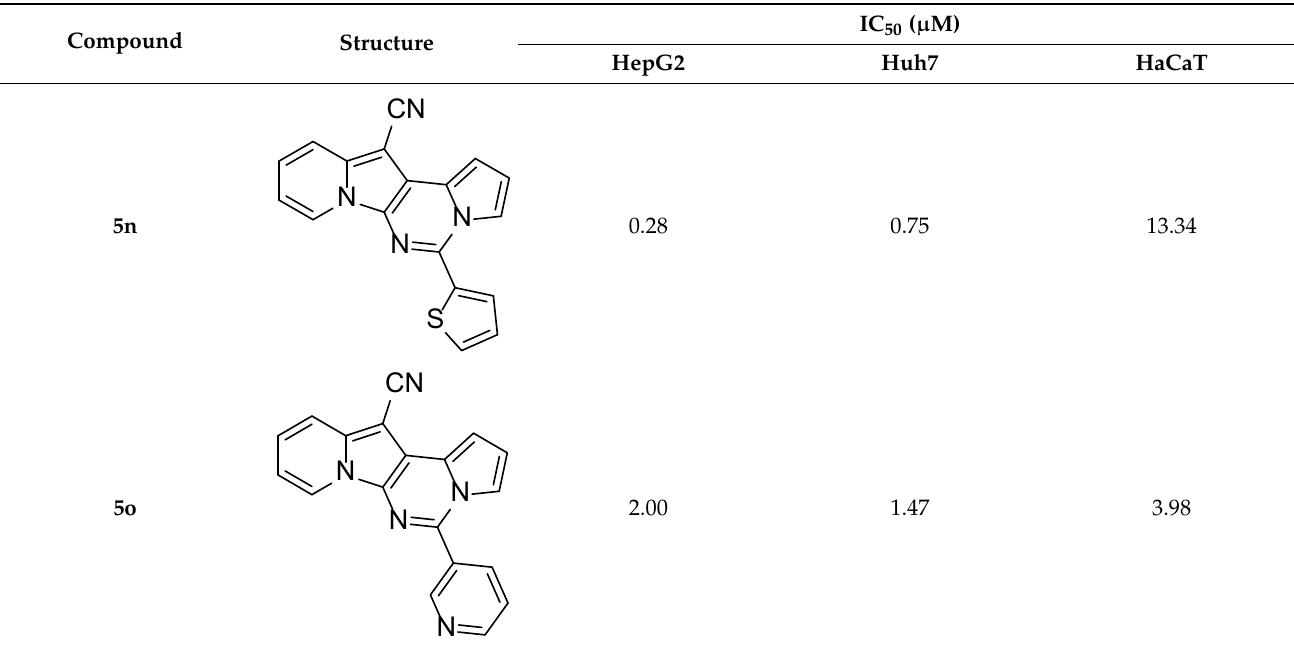
Table 3. Inhibitory effect of 5n–x and 10d on cell viability of HepG2, Huh7, and HaCaT cells (mean, n = 5).